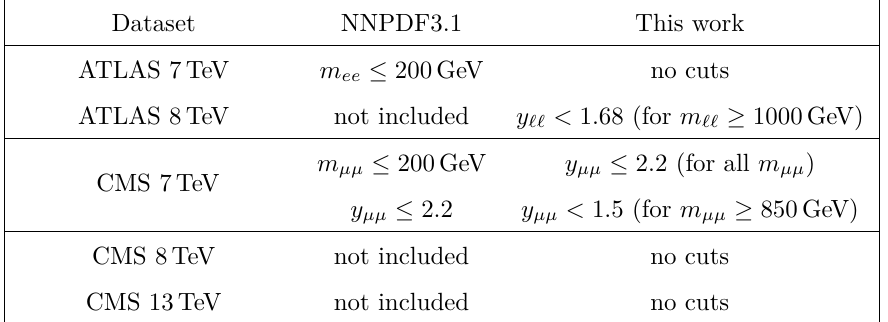
Figure 23 . The gluon-gluon, quark-antiquark, and quark-quark luminosities at function of m X for the DIS+DY baseline and for the same fit excluding the all the datapoints in the high-mass DY experimental sets listed in table. 2. The top panels display the ratio of luminosities to the central value of the DIS+DY baseline, while the bottom panels compare the relative PDF uncertainties in each case.